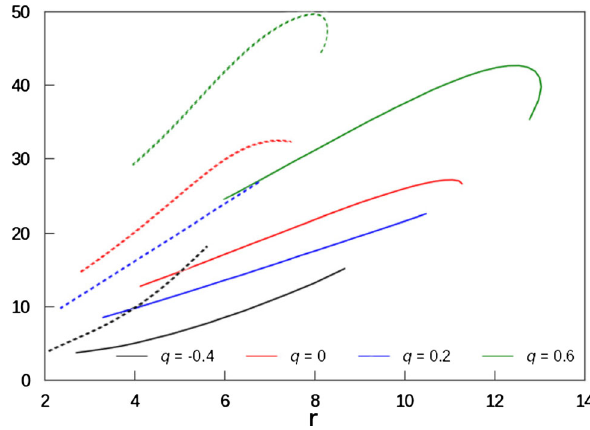
Fig. 8 The variation of (cid:17) 2 (dashed line) as a function of r mb , and the mb variation of (cid:17) 2 ms (thick line) as a function of r ms . Besides, the places of r mb and r ms also change with varying q and a . From the left to the right for each curve, a goes from negative to positive values